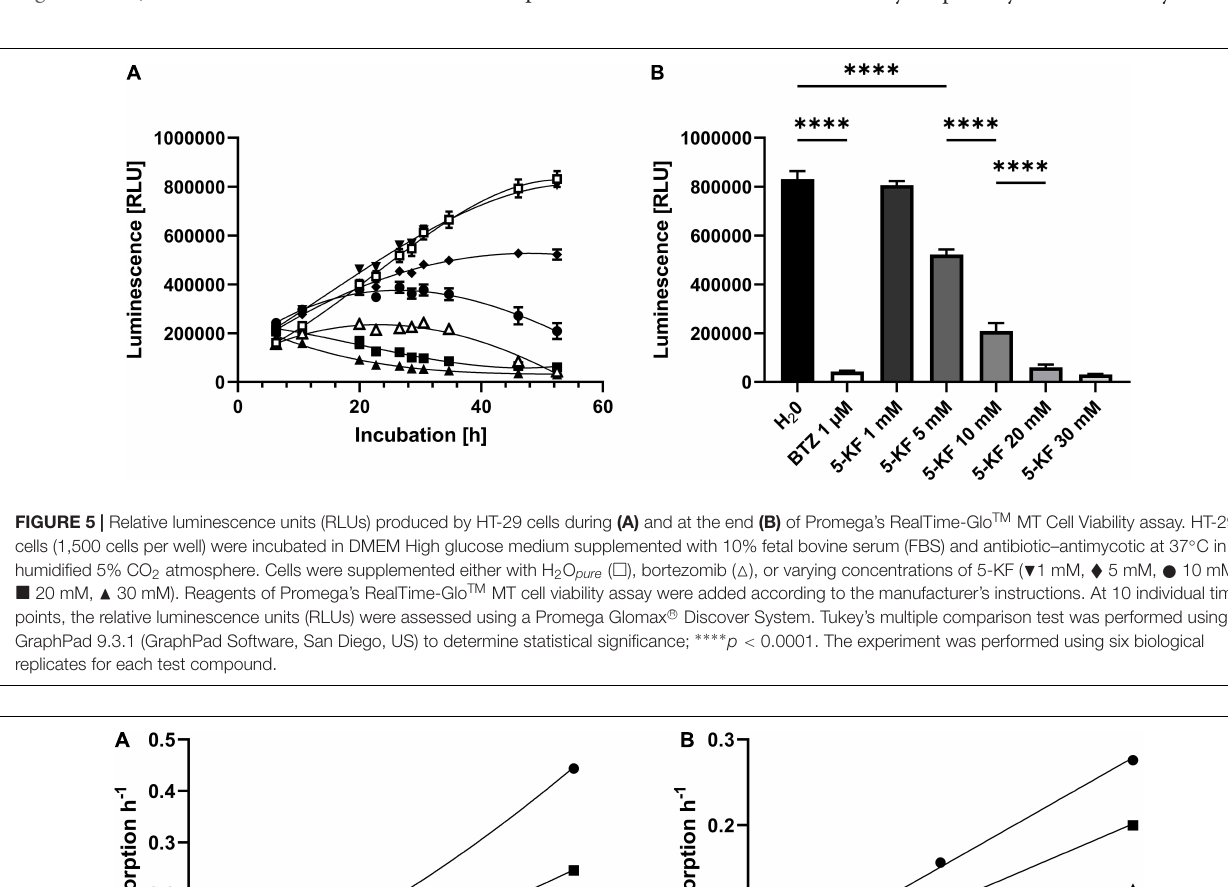
FIGURE 6 | Effect of ammonium chloride (A) and L -lysine (B) on the Maillard reaction induced by 5-KF and phosphate. Decreasing concentrations ( 40 mM, (cid:78) 20 mM, (cid:72) 10 mM, (cid:7) 5 mM, 2.5 mM, (cid:3) 0 mM) of ammonium chloride and L -lysine were incubated with 5-KF and phosphate at 37 ◦ C. Absorbance at 360 nm was measured every 15 min using a Tecan Infinite M200 plate reader (Tecan Group AG). Shown are the individual absorption changes per hour derived from (cid:35) the performed time-course